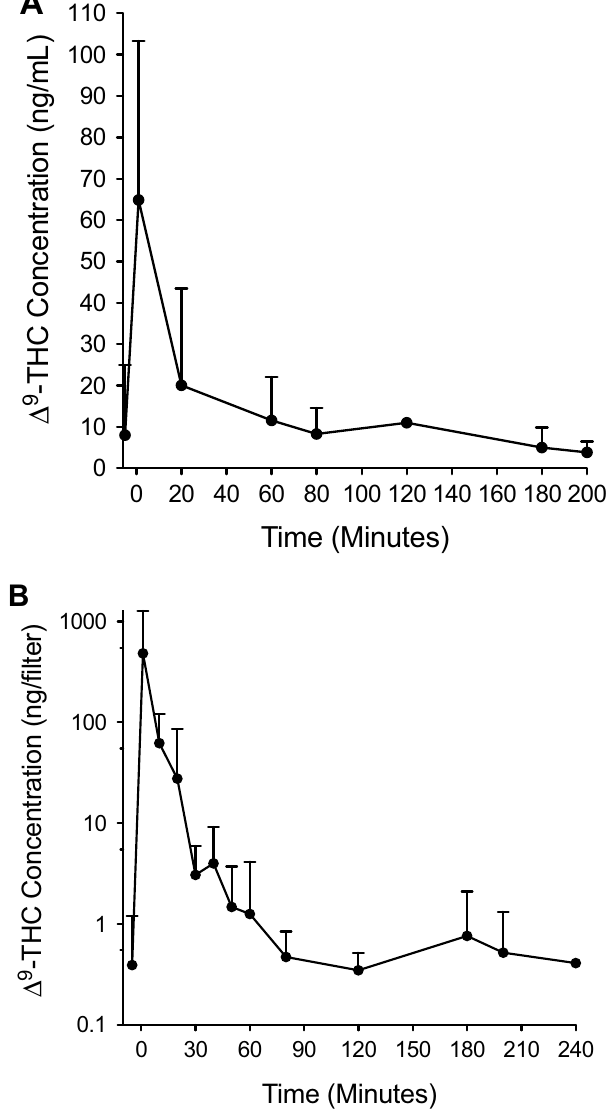
Figure 5. Relationship between blood and breath ∆ 9 -THC concentrations before and after smoking in 34 subjects. Average (+ SD) ∆ 9 -THC concentrations are shown in (A) blood (ng/mL) and (B) breath (ng/filter). Lack of error bars indicates N = 2. The number of subjects at each time point varies due to non-detection (ND) of ∆ 9 -THC, no sample (NS) collected, and removal of outliers. For blood, N = 32 prior to smoking (2 ND), 24 at 1 min post-smoking (10 NS), 25 at 20 min (9 NS), 33 at 60 min (1 outlier), 8 at 80 min (24 NS, 1 ND, 1 outlier), 2 at 120 min (32 NS), 22 at 180 min (8 NS, 2 ND, 2 outliers), and 12 at 200 min (21 NS, 1 ND). For breath, N = 23 prior to smoking (11 ND), 24 at 1 min post-smoking (9 NS, 1 outlier), 11 at 10 min (23 NS), 32 at 20 min (2 outliers), 11 at 30 min (23 NS), 20 at 40 min (14 NS), 11 at 50 min (23 NS), 25 at 60 min (9 NS), 10 at 80 min (23 NS, 1 ND), 3 at 120 min (31 NS), 26 at 180 min (7 NS, 1 ND), 3 at 200 min (30 NS, 1 ND), and 2 at 240 min (32